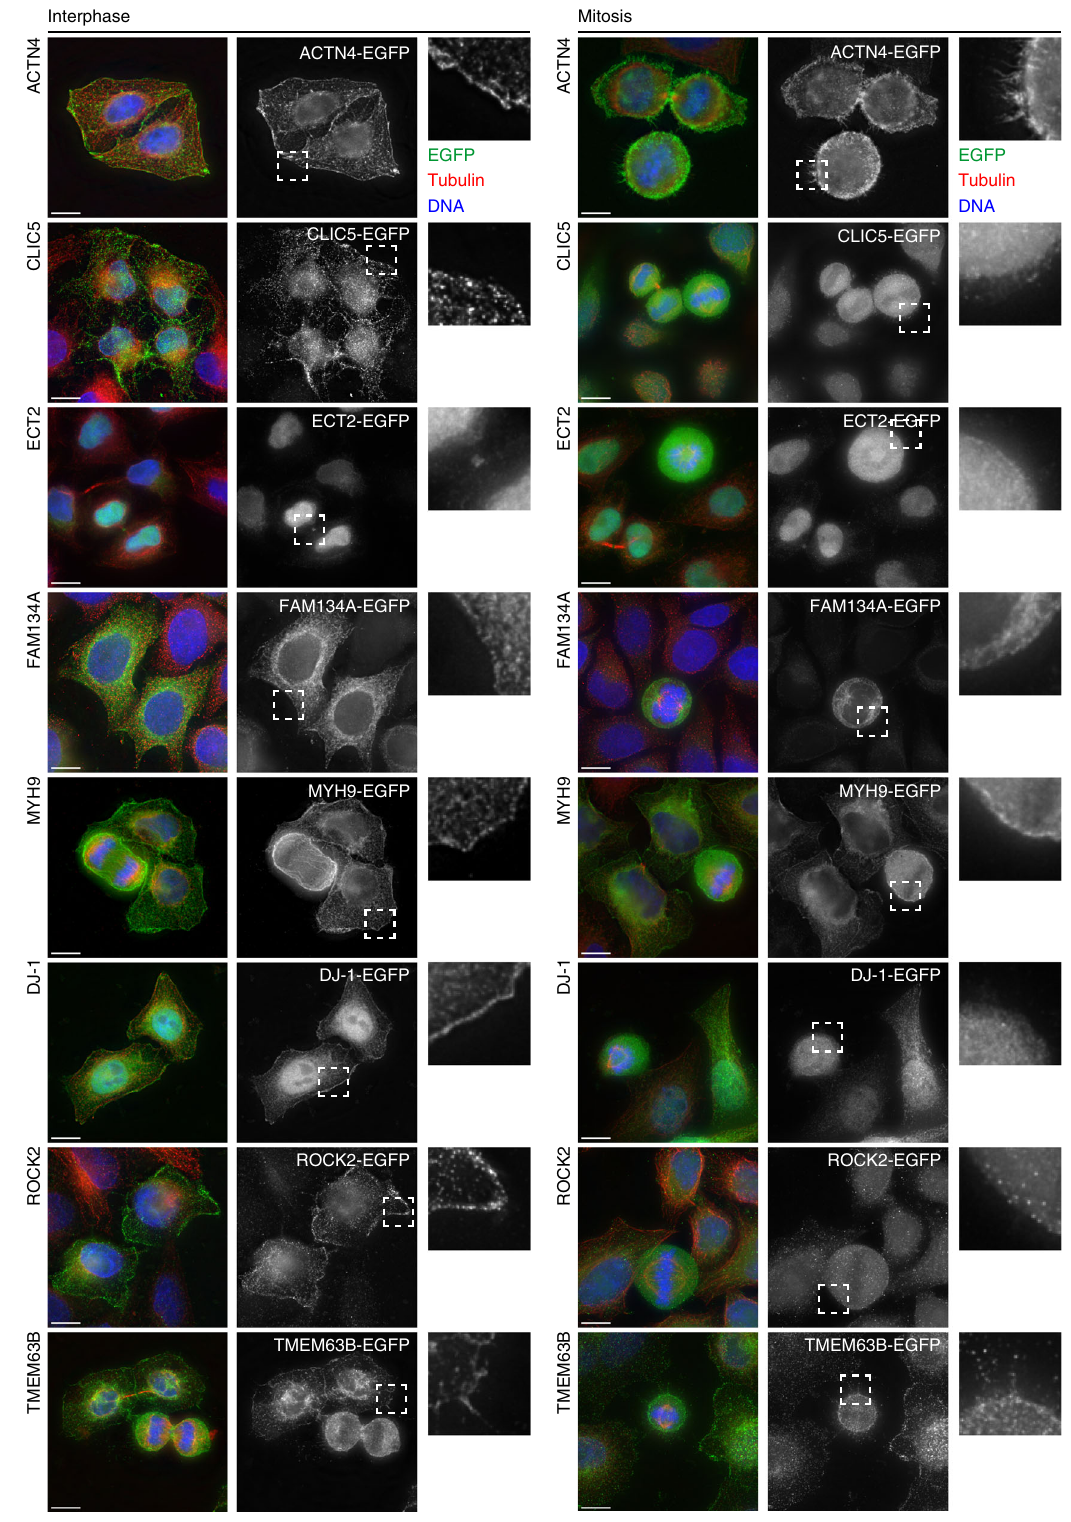
Fig. 2 Analysis of subcellular localization of selected mitotic cell mechanics proteins. Immuno fl uorescence images of fi xed HeLa interphase (left) and mitotic (right) cells expressing selected EGFP-tagged proteins, which were identi fi ed to result in decreased relative equilibrium rounding force when downregulated by RNAi. These proteins include ACTN4, CLIC5, ECT2, FAM134A, MYH9, DJ-1, ROCK2 and TMEM63B. Dashed boxes show the location of the EGFP-tagged protein at the cell cortex at higher magni fi cation. Blue, DNA (DAPI); Green/grey, EGFP (goat anti-GFP antibody/Alexa-488); Red, tubulin (mouse anti-alpha-tubulin/Alexa-594). Other relevant proteins had been tagged with EGFP using BAC TransgeneOmics 26 and are analyzed in Supplementary Fig. 4. Scale bars, 10 µ